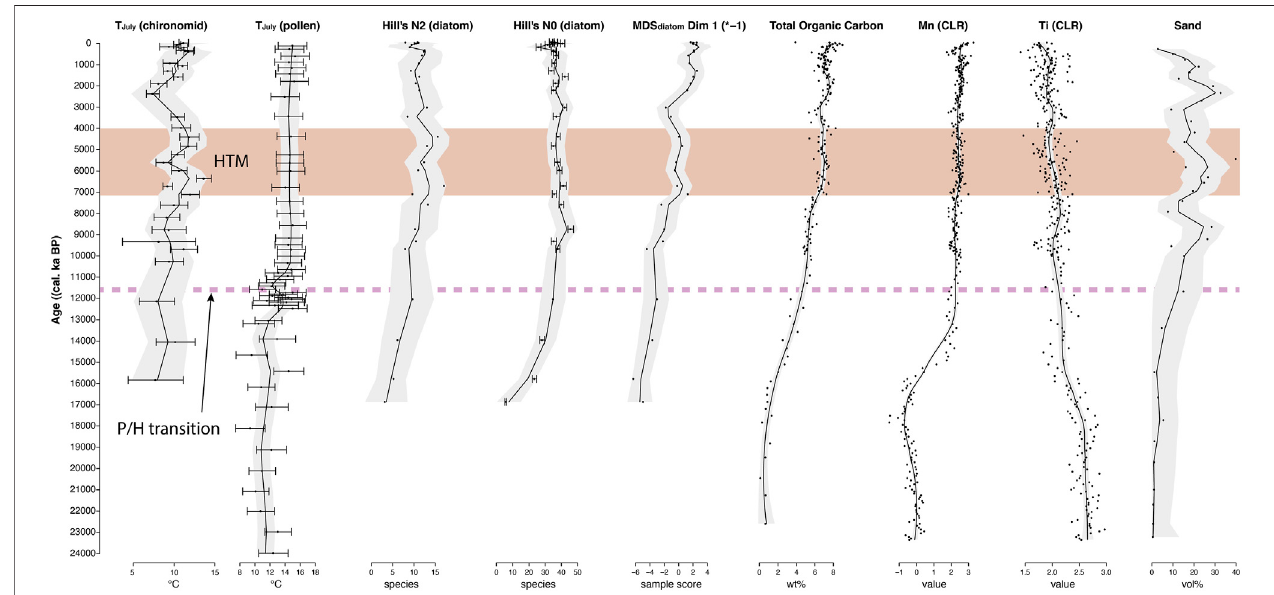
FIGURE8| Graphshowingsynchronizedvariablesusedforlead-lagcorrelations.Temperaturereconstructions(T July , ° C)bypollenarefromcorePG2133.Allother variables are from core PG2208: chironomids, diatom alpha diversity estimates (Hill ’ s N2, N0), MDS fi rst dimension Dim 1 (multiplied by − 1), organic carbon concentration, selected elements (CLR values), and total sand concentrations. Variables are drawn using their ages from PG2208 and PG2133 for pollen (Courtin et al., 2021). Smoothing and con fi dence intervals were gained using LOESS. The less reliable (lowermost four) samples were excluded from the chironomid data due to the low number of head capsules. HTM, Holocene thermal maximum; P/H, Pleistocene/Holocene transition.